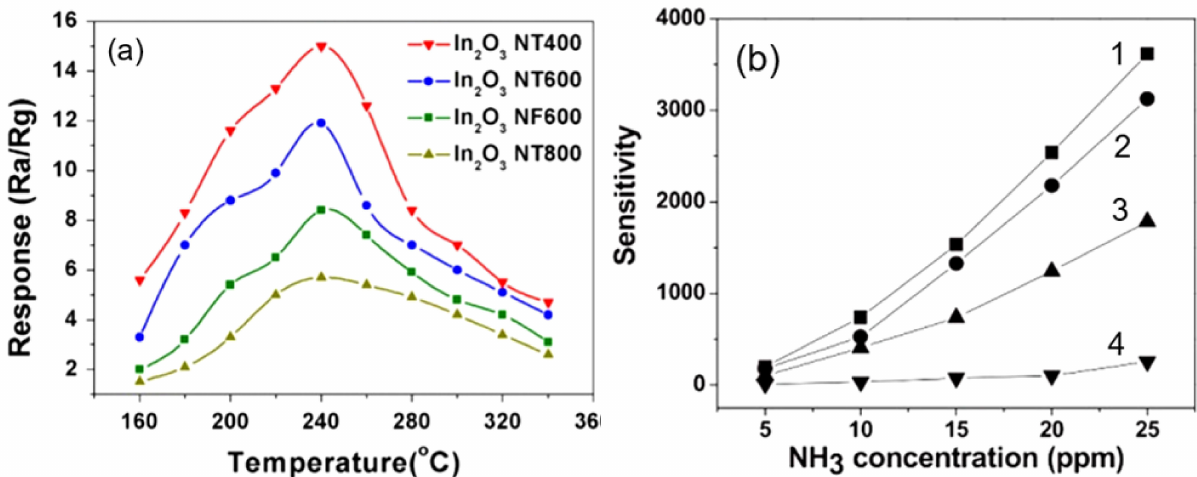
Figure 10. ( a ) Responses of In 2 O 3 nanofiber-based sensors to 50 ppm formaldehyde as a function of operating temperature and the temperature of calcination ( t = 3 h, T c = 400–800 ◦ C). Reprinted with permission from [171]. Copyright 2016 Elsevier. ( b ) Conductivity response to NH 3 (5–25 ppm) at room temperature for four types of gas sensors based on In 2 O 3 nanostructures: 1—broken In 2 O 3 hollow nanofiber; 2—regular In 2 O 3 hollow nanofiber; 3—In 2 O 3 nanofiber; 4—In 2 O 3 nanoparticles. Adapted with permission from [140]. Copyrights 2007